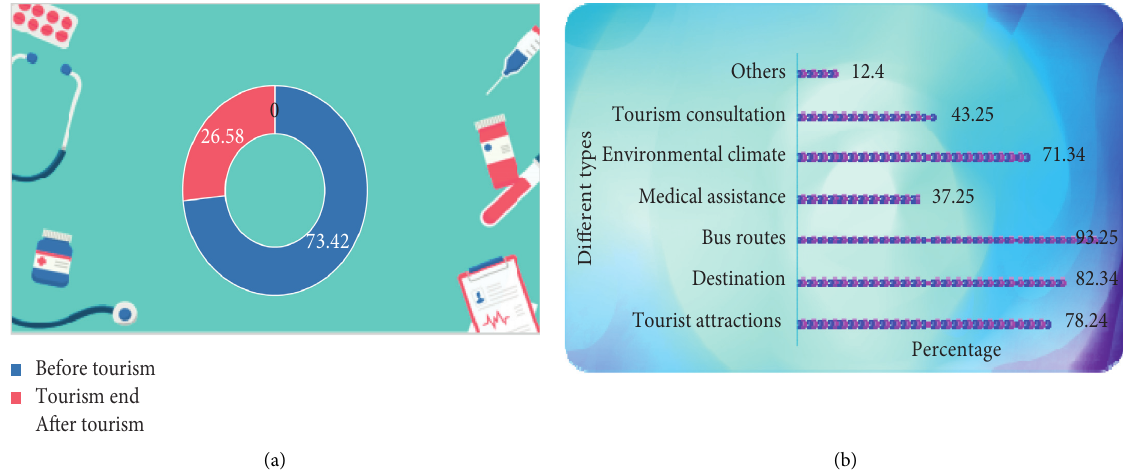
Figure 4: (a) Distribution stage of tourism information demand. (b) Content analysis of tourism information demand.